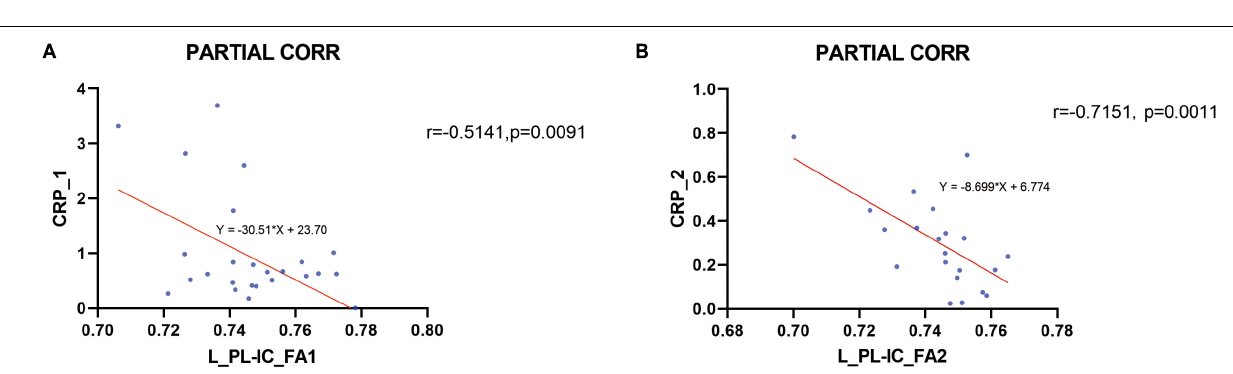
FIGURE 3 | Correlation between the peripheral hs-CRP levels and the FA in the left posterior limb of the internal capsule (L_PL-IC) before and after treatment. An inverse correlation between the FA values in the left posterior limb of the internal capsule (L_PL-IC) and peripheral hs-CRP levels in both before and after treatment patients was found when controlling for age, duration, and education by partial correlation ( A pretreatment, B